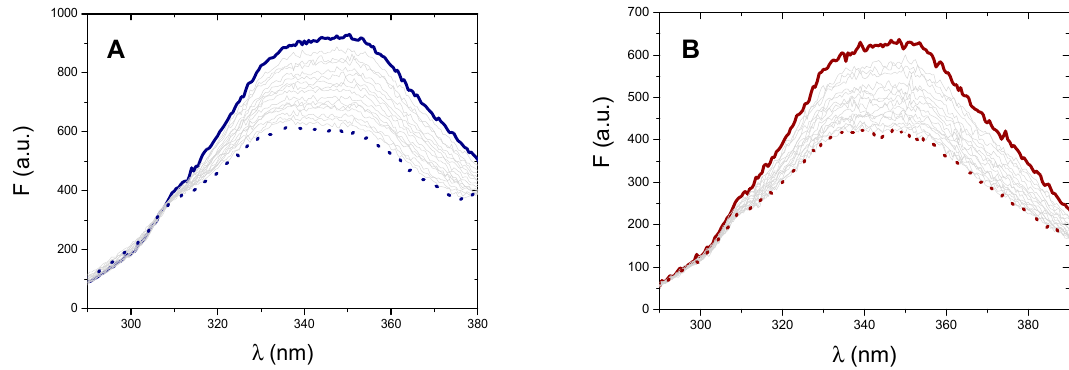
Figure 6. ( A ) Fluorescence spectra of BSA 3.14 × 10 − 7 M alone (full line) and ( A ) in the presence of increasing amounts of [Ag(EIA) 2 ] + , from 0 M to 2.37 × 10 − 6 M; ( B ) in the presence of increasing amounts of [Au(EIA) 2 ] + , from 0 M to 3.10 × 10 − 6 M (dotted line). λ ex = 280 nm, NaCl 0.1 M, NaCac 2.5 mM, pH = 7.0, T = 27 °C.